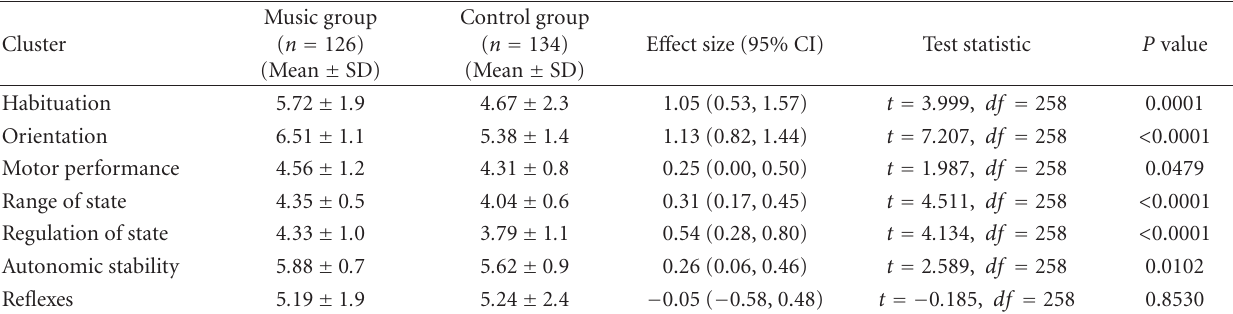
Table 2: Comparison of BNBAS clusters scores between music and control